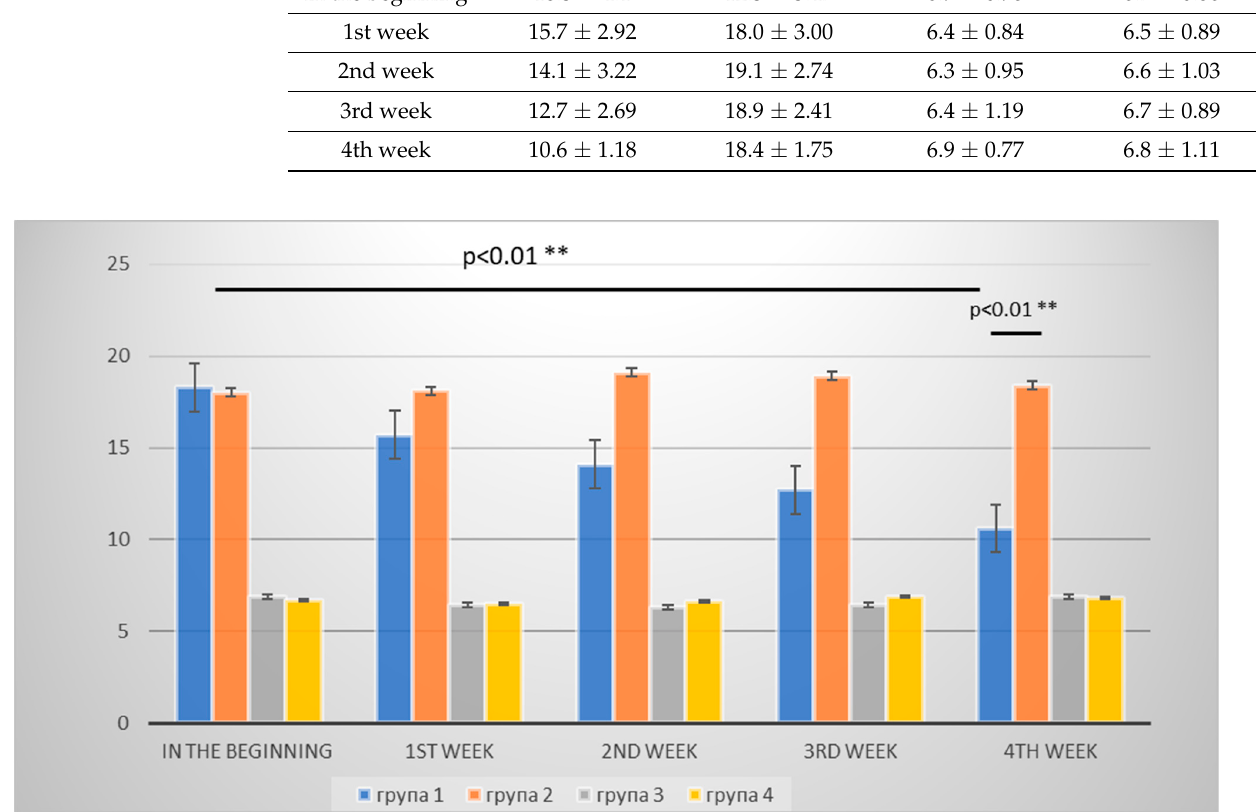
Table 4. Average levels of immunoreactive insulin, measured in mIU/mL, in the different groups during the study ± standard deviation (SD). Group 1